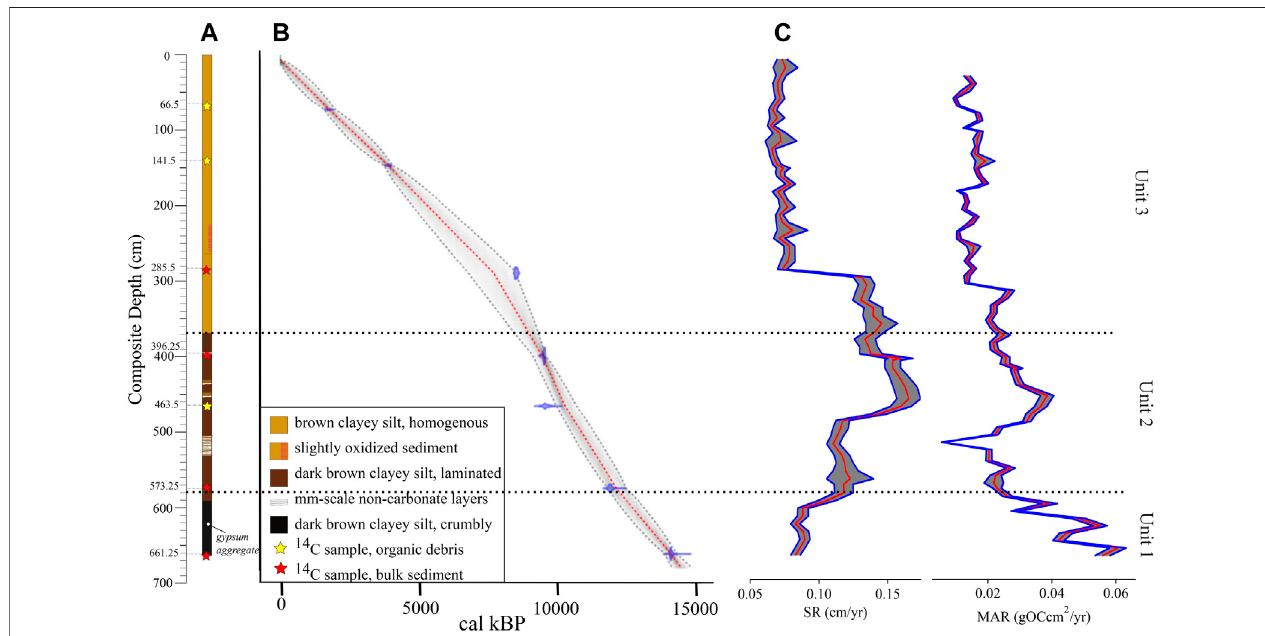
FIGURE 2 | (A) General stratigraphy and (B) age-depth model of the sediment core, based on radiocarbon dating of 7 samples, shown as green/yellow stars (see details in Table 1 ). (C) Inferred sedimentation and mass accumulation rate (SR and MAR) curves along the core, based on the age-depth model.